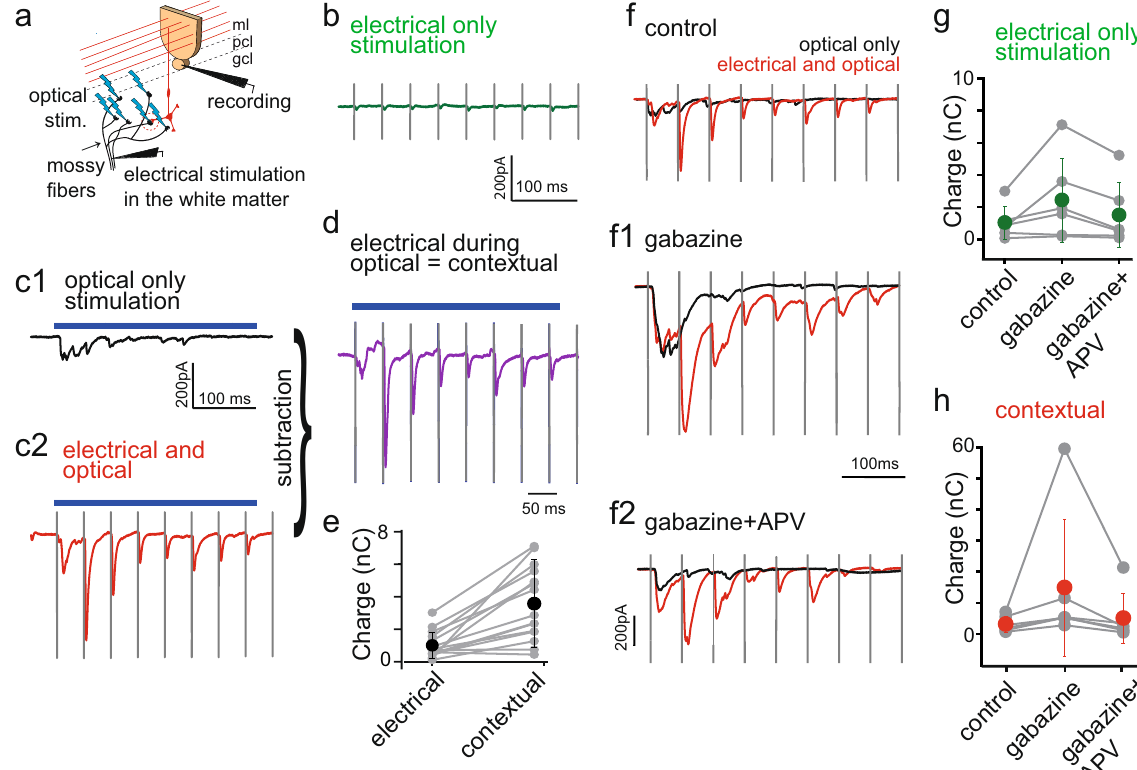
Figure 6. Contextual gating of salient mossy fiber inputs by ongoing optogenetic stimulation. ( a ) Schematic drawing explaining experimental pairing protocol. Cerebellar cortex output activity was measured by recording Purkinje cells in whole-cell configuration. Minimal electrical stimulation of mossy fibers was applied by placing stimulation electrode few hundreds of µ m away from the recorded cell body and applying 1 ms pulse at 20 Hz (50 ms interpulse interval) for 4 s. This input was superimposed with the asynchronous stimulation evoked optically (represented by blue lightings), similarly as in previous experiments (Fig. 5). ( b ) Examples of traces from a single cell showing response recorded in Purkinje cell to electrical only stimulation. ( c ) Examples of traces from a single cell showing response recorded in Purkinje cell to ( c1 ) optical only stimulation, ( c2 ) paired electrical and optical stimulation. ( d ) Trace presenting net electrical stimulation in the context of optical stimulation (contextual charge transfer), calculated by subtracting optical only stimulation from the paired stimulation. ( e ) Summary of the contextual charge transfer (calculated as in d) during the whole period of paired electrical and optical recording; blue dots represent averages ± s.d., grey pairs of points represent single cells (n = 15). ( f ) Contextual gating in the granular layer is under the control of Golgi cell. Examples of traces from a single cell showing response recorded in Purkinje cell to optical only (black trace) or paired electrical and optical stimulation (red trace) in ( f ) control condition, ( f1 ) after gabazine and ( f2 ) gabazine and APV bath- application (same cell as in c1-c2). ( g ) Summary of average charge transfer during the electrical only stimulation in three pharmacological conditions: control, bath applied gabazine and bath applied gabazine and APV; error bars represents ± s.d. (n = 6). ( h ) Summary of the contextual charge transfer (calculated as for d and e) in three pharmacological conditions (n = 6). Vertical lines in b, c1-c2,d and f-f2 are electrical stimulation artefacts to better visualize the timing of the evoked responses; horizontal, blue dashed line represents optical